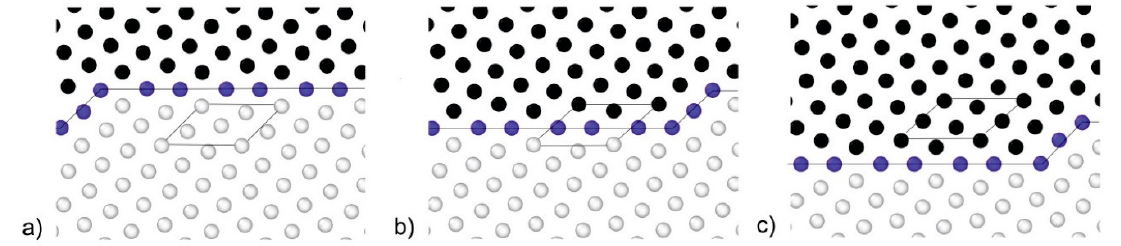
Figure 14. Passage of disconnection step through selected volume. Atoms of parent and twin crystals are shown as white and black circles, respectively. Atoms in {1012} twin boundary are shown as blue circles. Parallelogram indicates selected volume. ( a ) Selected volume is located in parent crystal. Disconnection is present as step in the twin boundary. ( b ) Disconnection migrates to the right and causes twin boundary migration downwards. The twin boundary intersects selected volume. ( c ) Migration of another disconnection leads to further migration of {1012} twin boundary. Selected volume is located in twin crystal now.